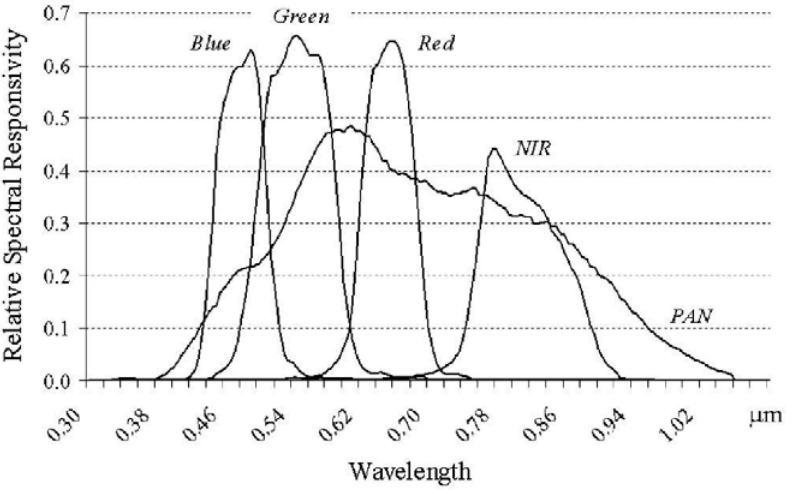
Figure 1. Spectral response functions for QuickBird-2